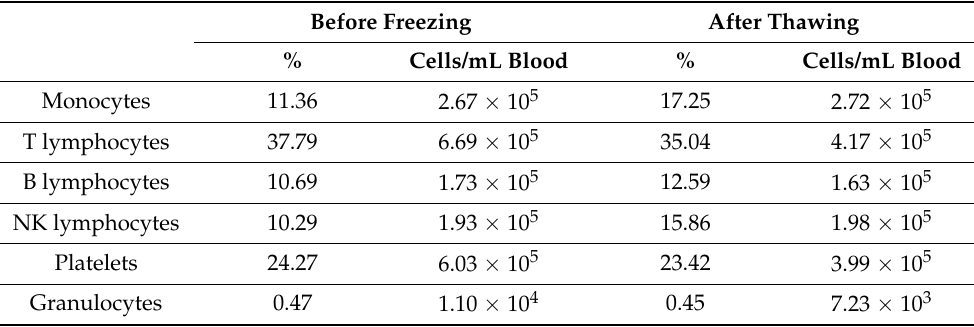
Table 1. Average proportion and quantification of Ficoll-purified PBMC populations by flow cytome- try immunophenotyping before and after cryopreservation. N = 15. Before Freezing After